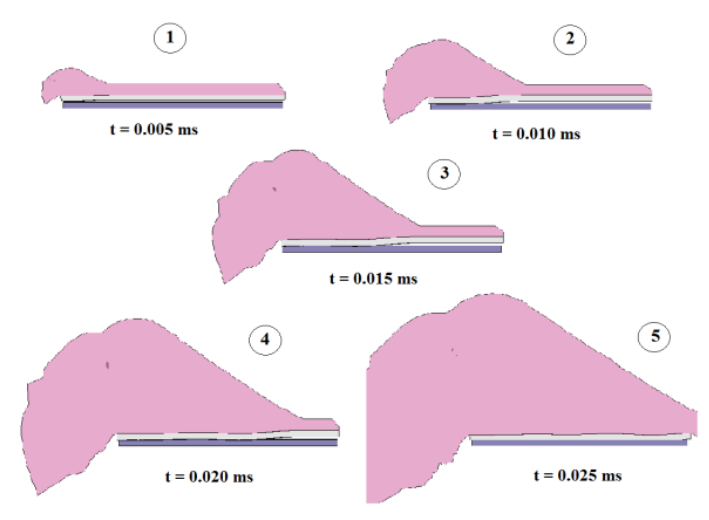
Figure 5. Composite plate welded by explosion.